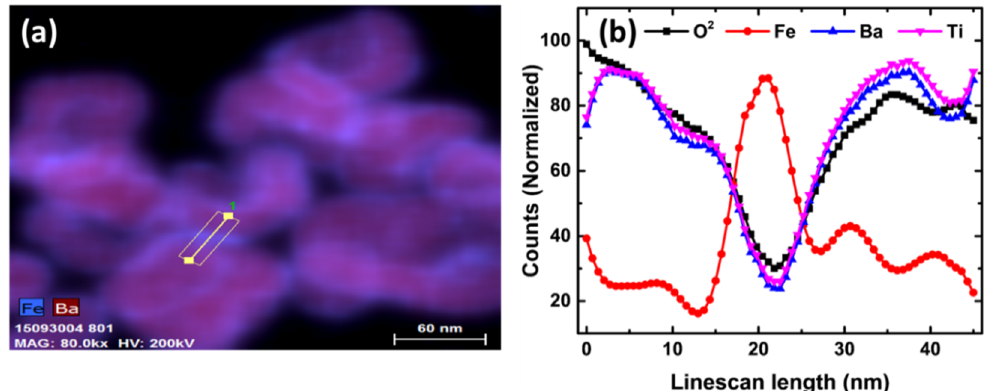
Figure 3. ( a ) TEM-EDX showing Fe and Ba intensities at the region of interest for the quantitative analysis (yellow line) and ( b ) normalized intensity along the yellow line.